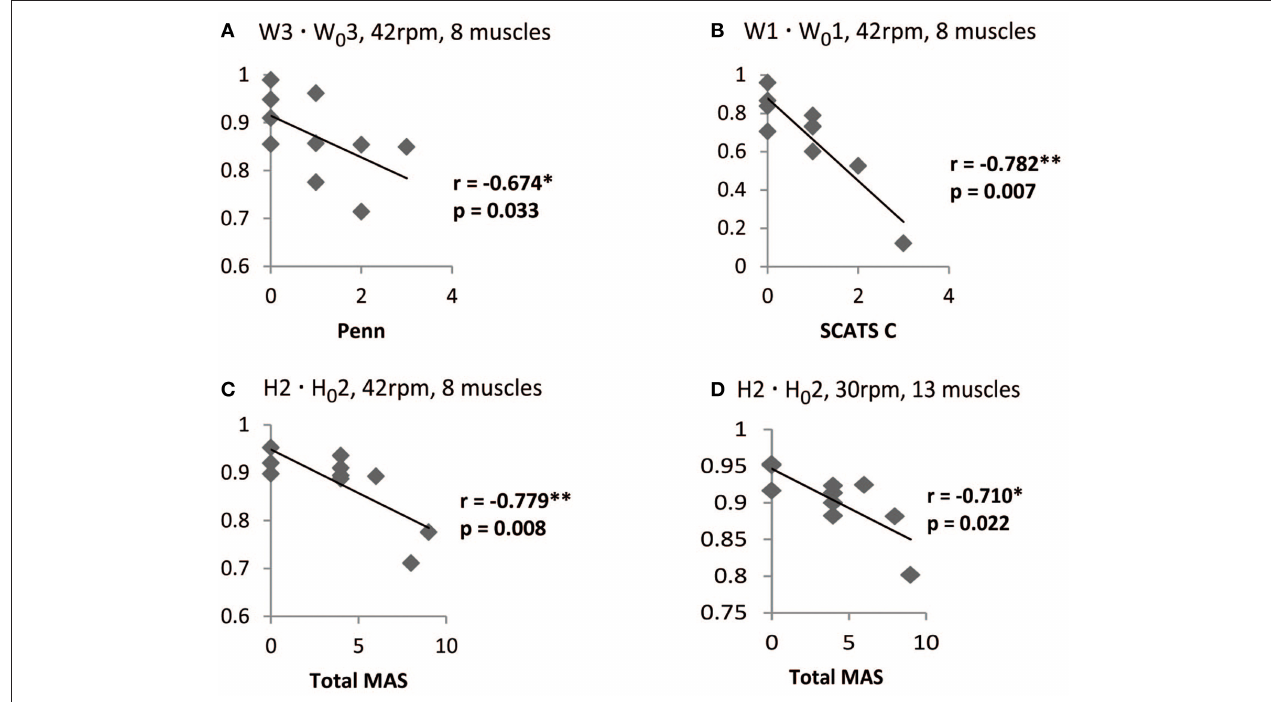
FIGURE 5 | Correlation between spasticity scales in iSCI patients and W · W 0 , and H · H 0 scores. For the set of 8 muscles at 42rpm, W3 · W 0 3 correlated negatively with PENN (A) and W1 · W 0 1 correlated negatively with clonus spasms assessed with SCATS (B) . H2 · H 0 2 correlated negatively with Ashworth for the sets of 8 muscles at 42rpm (C) and 13 muscles at 30rpm (D) . * Correlation is significant at the 0.05 level (2-tailed). ** Correlation is significant at the 0.01 level